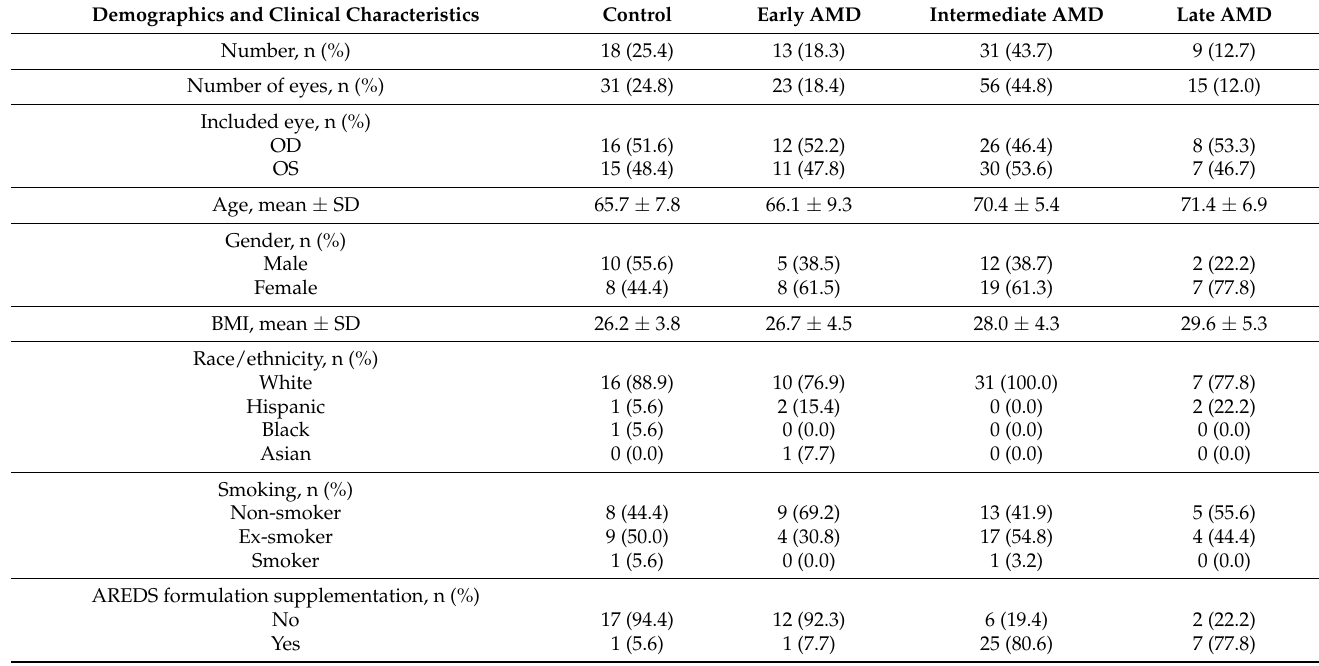
Table 1. Clinical and demographic characteristics of the study